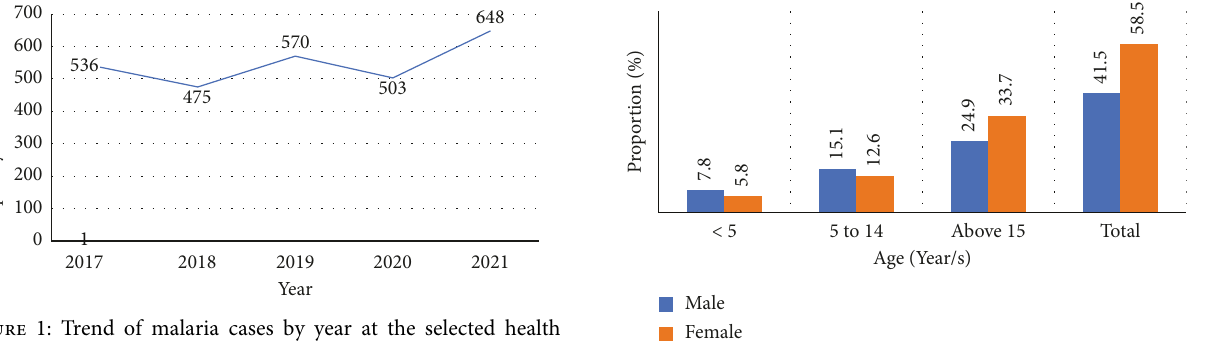
Figure 3: Proportion of malaria cases by age and sex in Decha and Gimbo districts, Southwest Ethiopia (2017-2021).